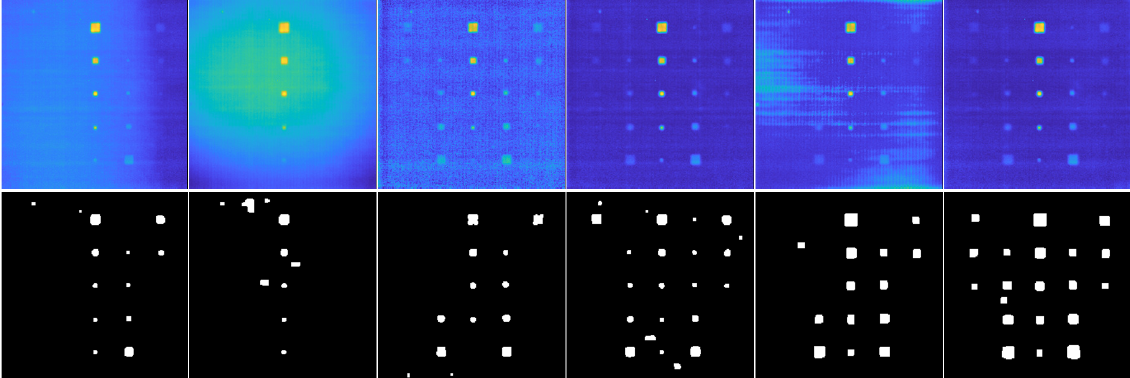
Figure 6. Automated defect detection in actual thermal sequence maxigrams of a CFRP sample. Row No. 1: Maxigrams of sequences contrast-enhanced with different techniques. Column: No. 1: CN, No. 2: DAC, No. 3: BTCF, No. 4: BTCFN, No. 5: BTCOp and No. 6: BTCOpN. Row No. 2: